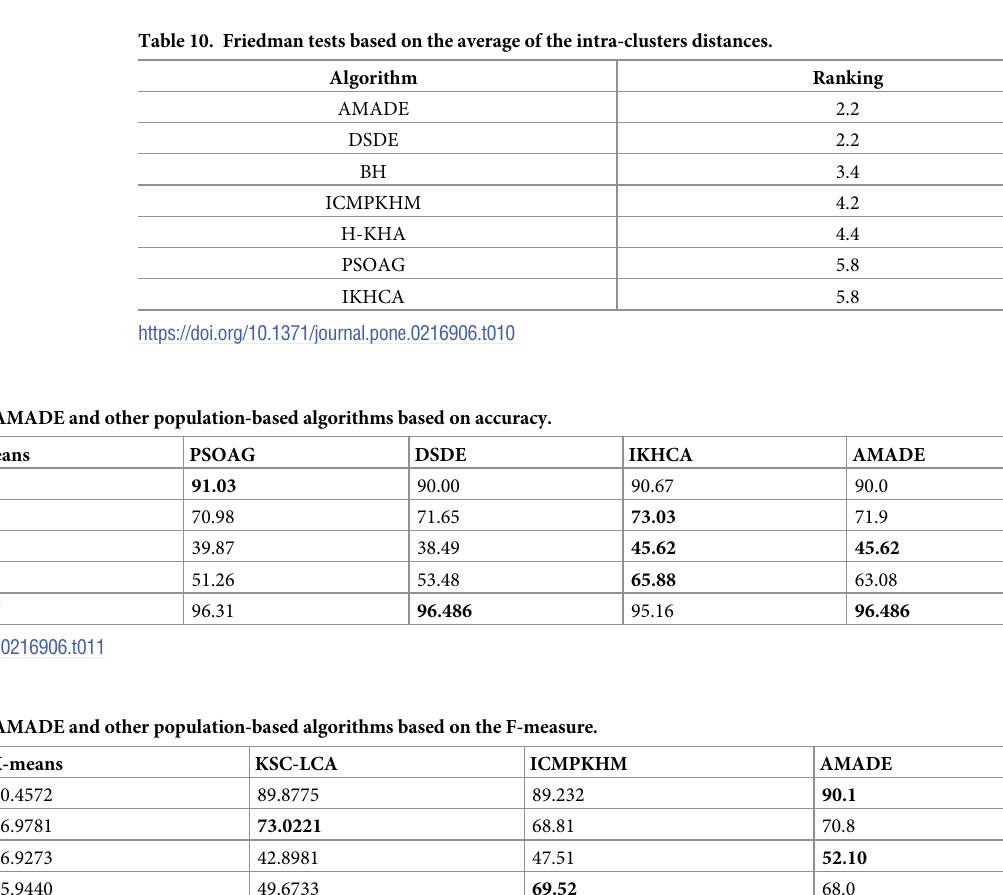
Table 12. Comparison between AMADE and other population-based algorithms based on the F-measure. Data Set K-means Iris Wine Glass